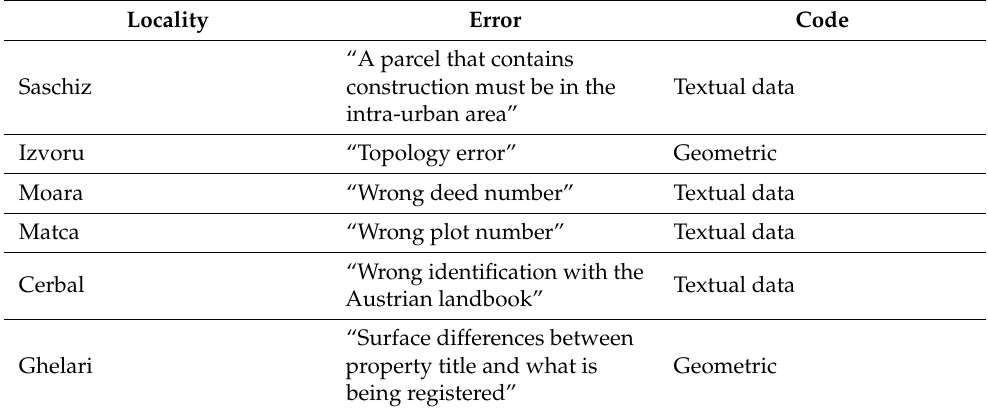
Table A1. Example of the coding